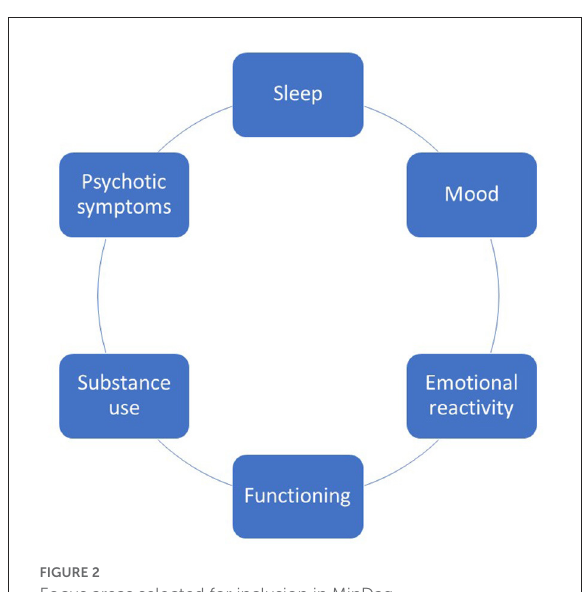
FIGURE2 Focus areas selected for inclusion in